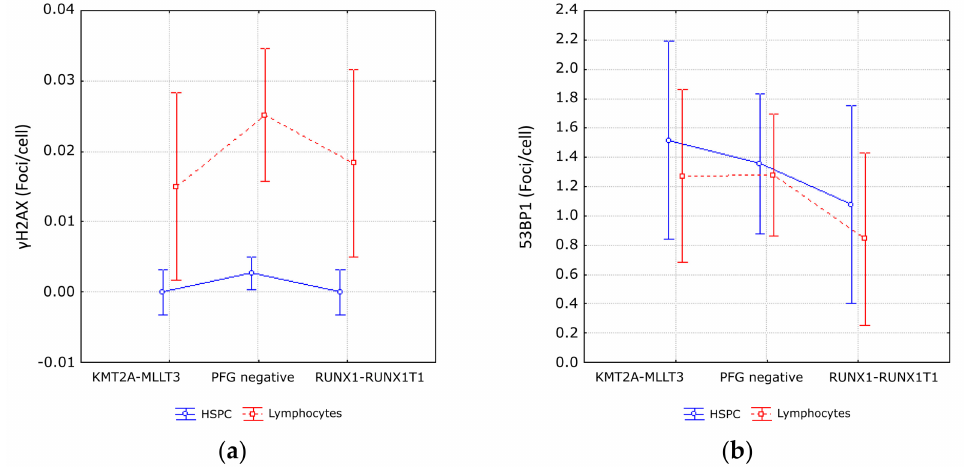
Figure 5. DNA repair foci in UCB cells of PFG + and PFG − probands. ( a ) γ H2AX foci. ( b ) 53BP1 foci. Data for lymphocytes and HSPCs are presented. Mean values of foci per cell from 3 RUNX1- RUNX1T1 PFG + , 3 KMT2A-MLLT3 PFG + , and 3 PFG − probands are displayed along with 95% confidence